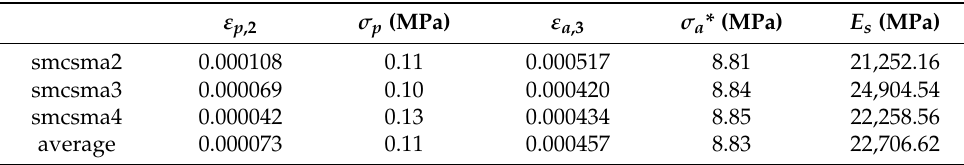
Table 5. Secant modulus of elasticity of sprayed mortar.